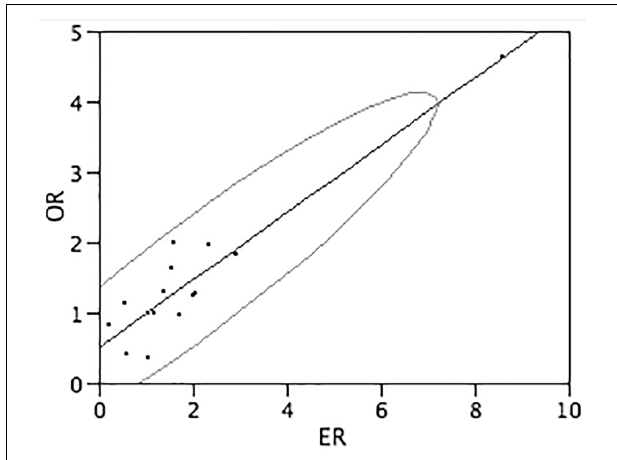
FIGURE 3 | Correlation between observed end expected gene expression ratios. The graph shows the correlation between the gene expression ratios observed ( Y -axis) and expected ( X -axis) calculated by bivariate analysis by JMP 5.1 program. Assuming that the variables have a bivariate normal distribution, the ellipse (Bivariate Normal Ellipse) contains about 95% of the points. The narrowness of the ellipse shows the correlation of the variables. If the ellipse is narrow and diagonally oriented, the variables are related. Pearson correlation coefficient = 0.93 and p -value < 0.0001.